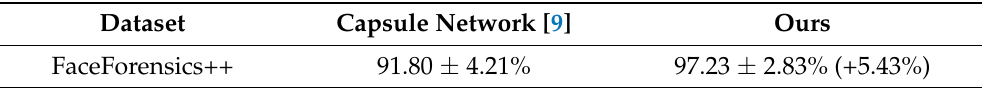
Table 2. Comparison of the accuracy and the uncertainty of the proposed method and the original capsule network on the FaceForensics++